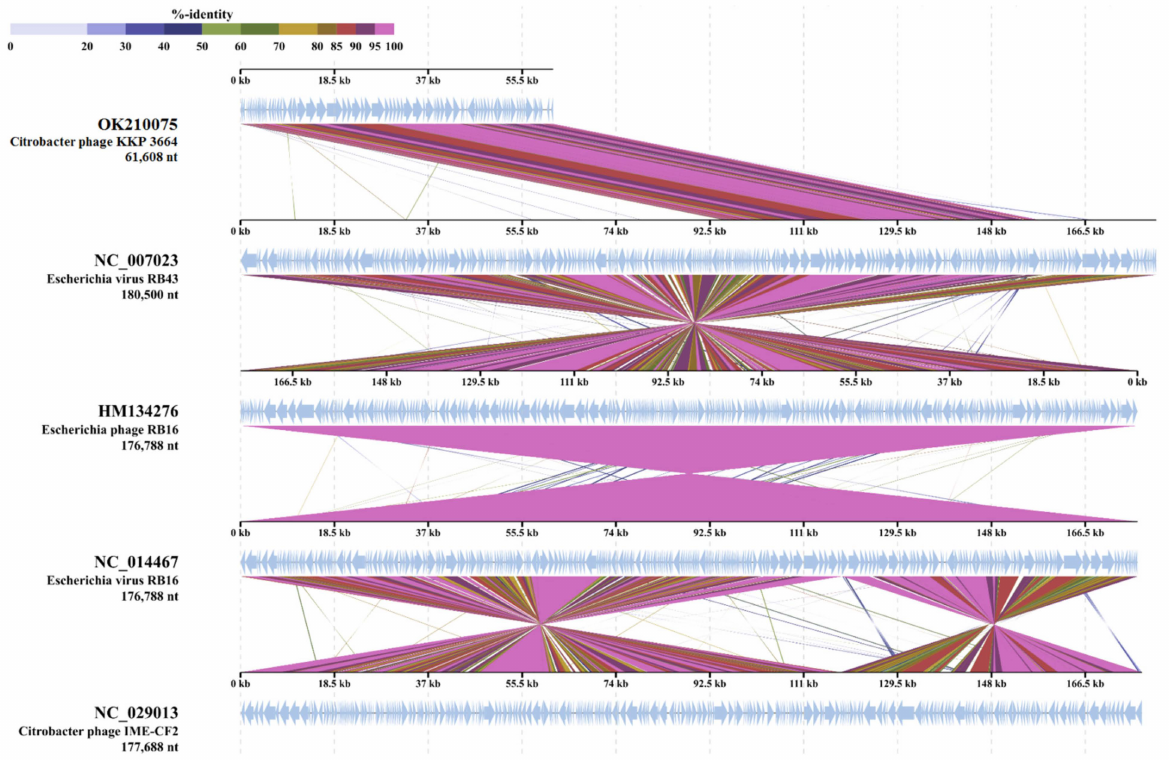
Figure 13. Genome sequence comparison of the Citrobacter phage KKP 3664 with four other Myoviridae -related phage genomes exhibiting co-linearity detected by TBLASTX using ViPTree server [84]. Homologous regions detected by a TBLASTX search are connected by segments colored based on amino acid identity. The color bar shows the % identity of